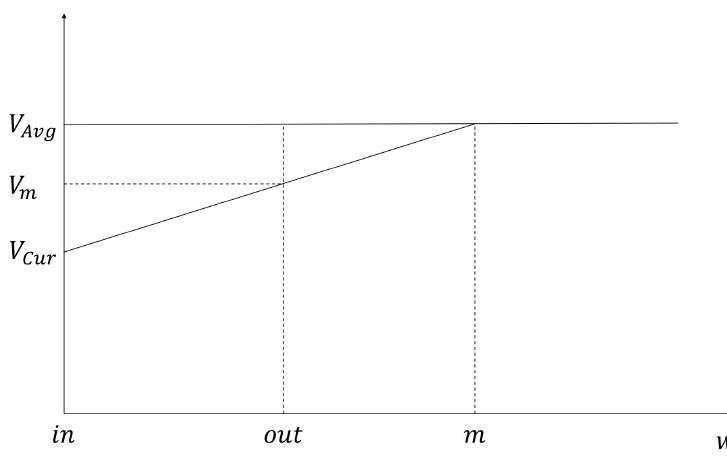
Figure A1. The location of m when a is small.